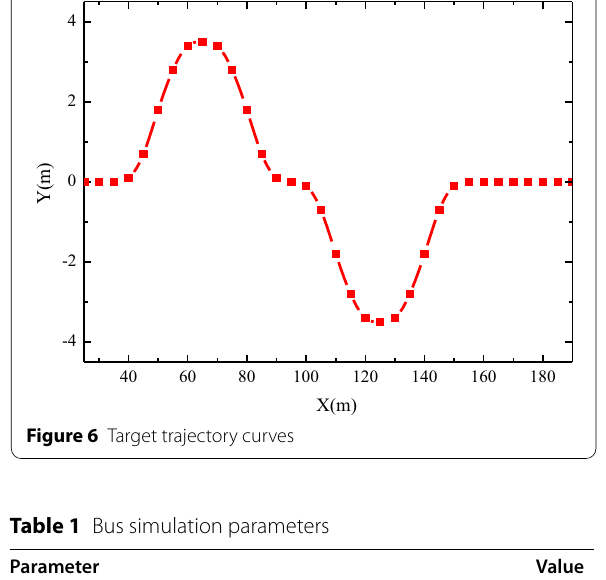
Figure 6 Target trajectory curves